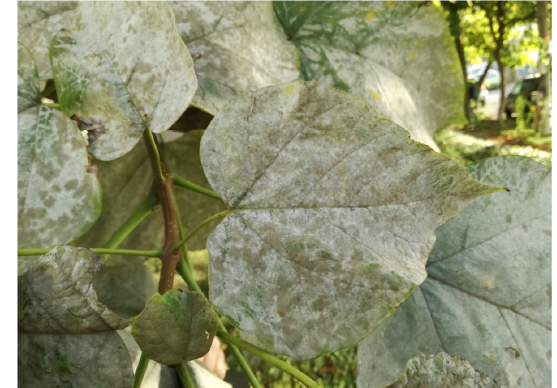
Fig. 2. Catalpa bignonioides , powdery mildew symptoms on